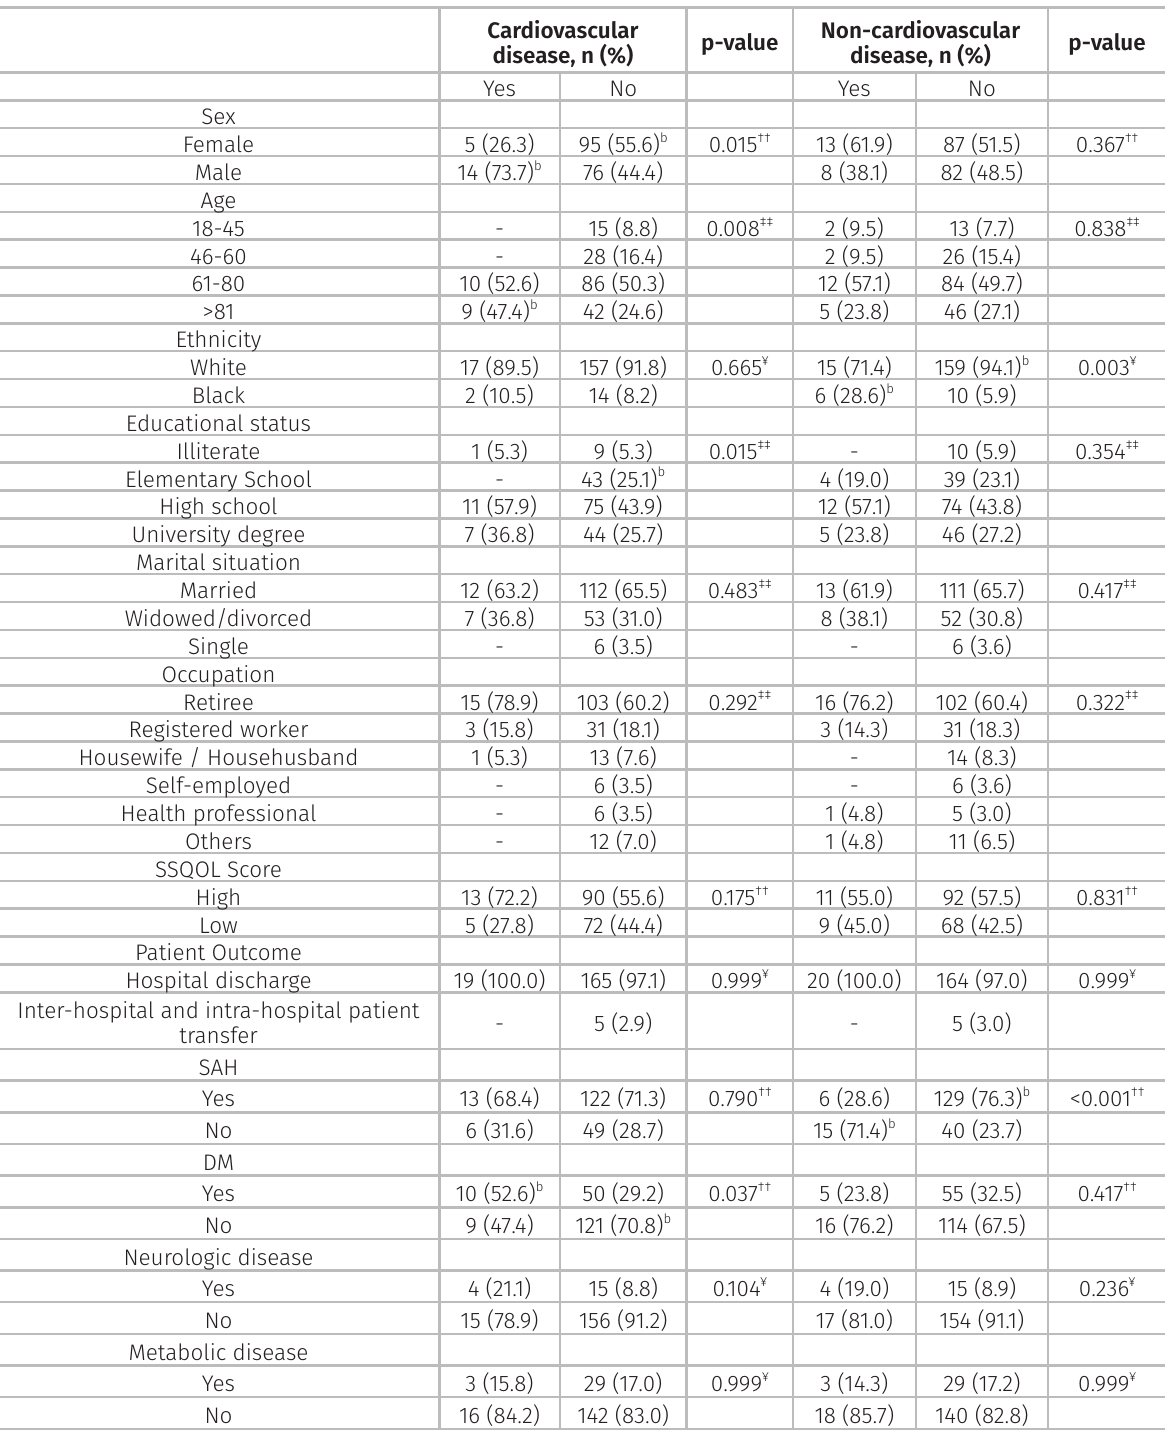
Table II. Correlations of sociodemographic and HRQOL with risk factors characteristics in adult population admitted by stroke diagnosis in a private hospital in southern